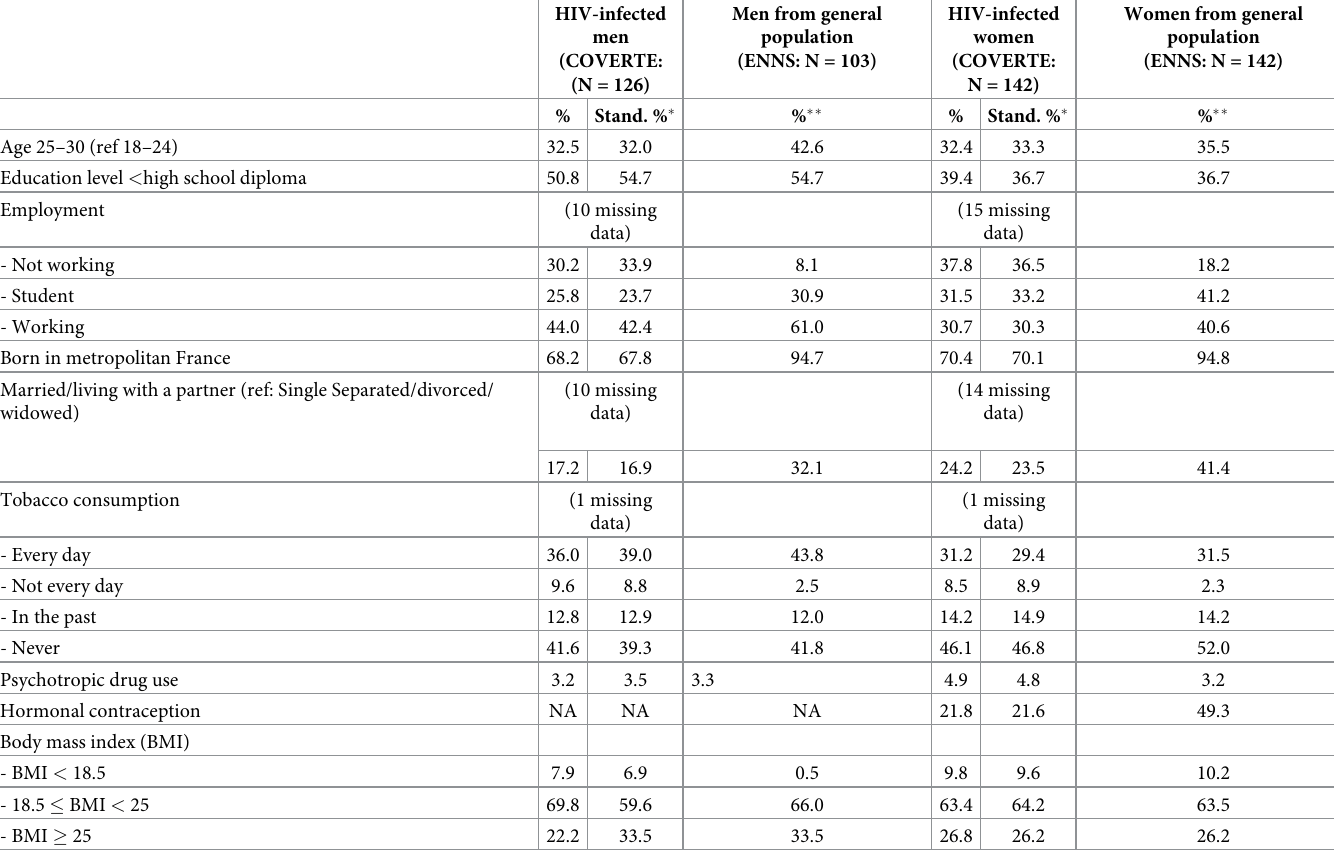
Table 1. Sociodemographic and behavioral characteristics of patients infected with HIV since childhood (ANRS COVERTE Cohort) and the French general popula- tion (ENNS).